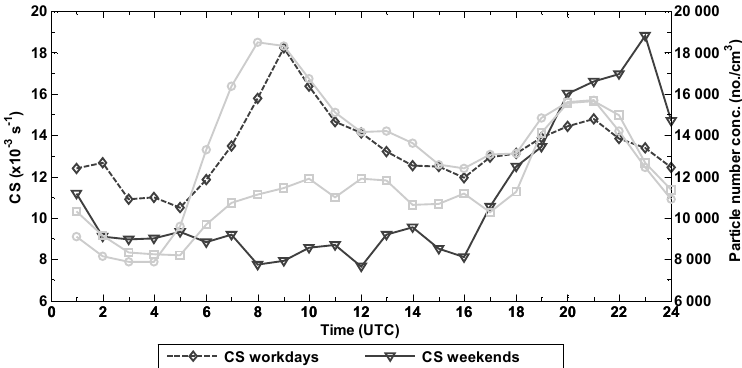
Figure A3. Diurnal cycle of condensation sink (CS) based on data from 1 to 31 July 2009 and 15 January to 15 February 2010 (1h resolution) and particle number concentrations. The markers represents median of hourly means.